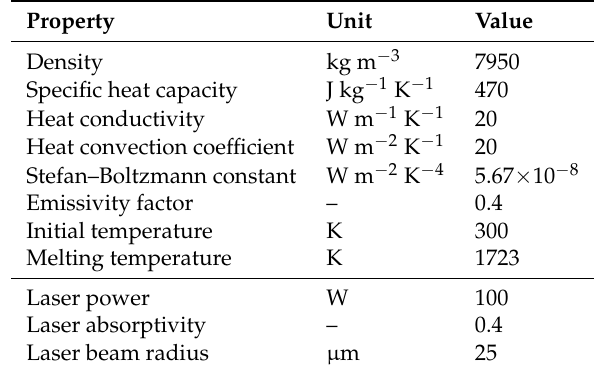
Table 2. Parameters and material properties used according to